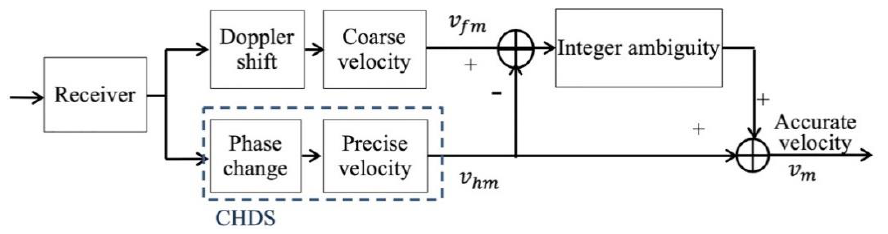
Figure 1. The process of velocity measured by coherent Doppler sonar assisted by frequency shift (CHDSF).